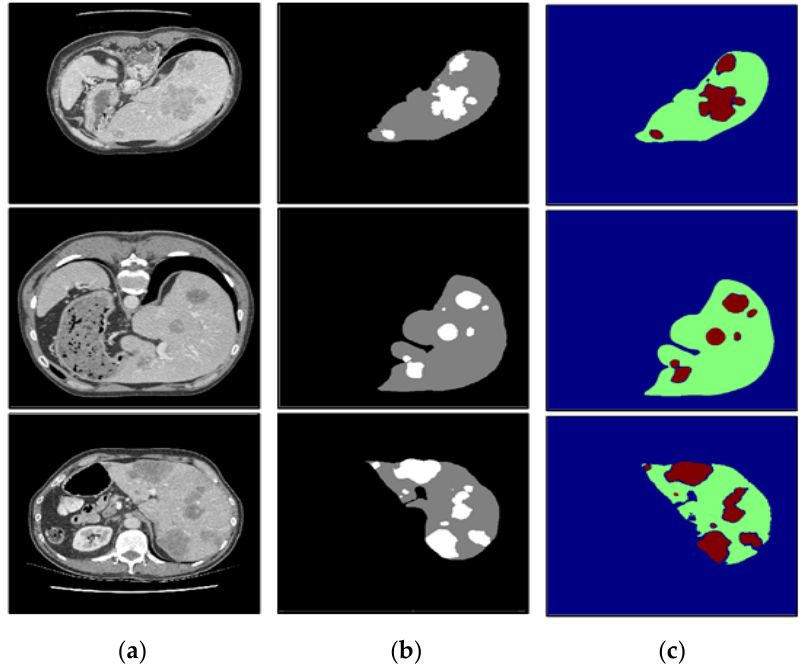
Figure 12. The segmentation results of our algorithm for multiple liver tumors: ( a ) CT original images; ( b ) the real segmentation results; ( c ) our segmentation results.